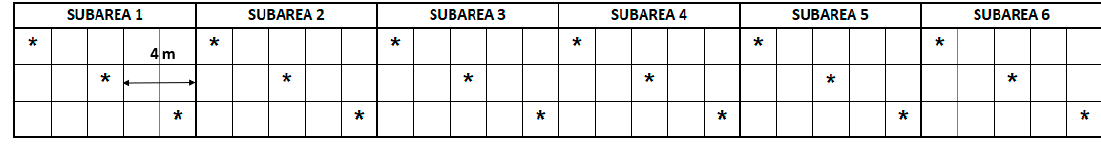
Figure S1: gametophytes grown on Petri dishes, Figure S2: sporophytes on pots filled with quartz sand. Figure S3: sporophytes planted on field. Figure S4: tunnels covering the ferns during